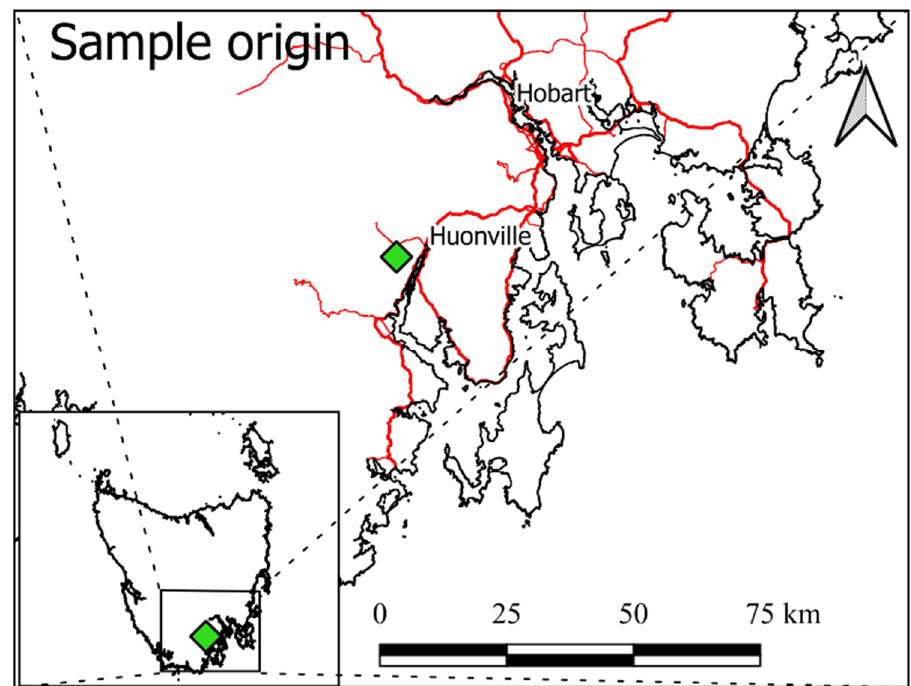
Figure 2. Resource origin